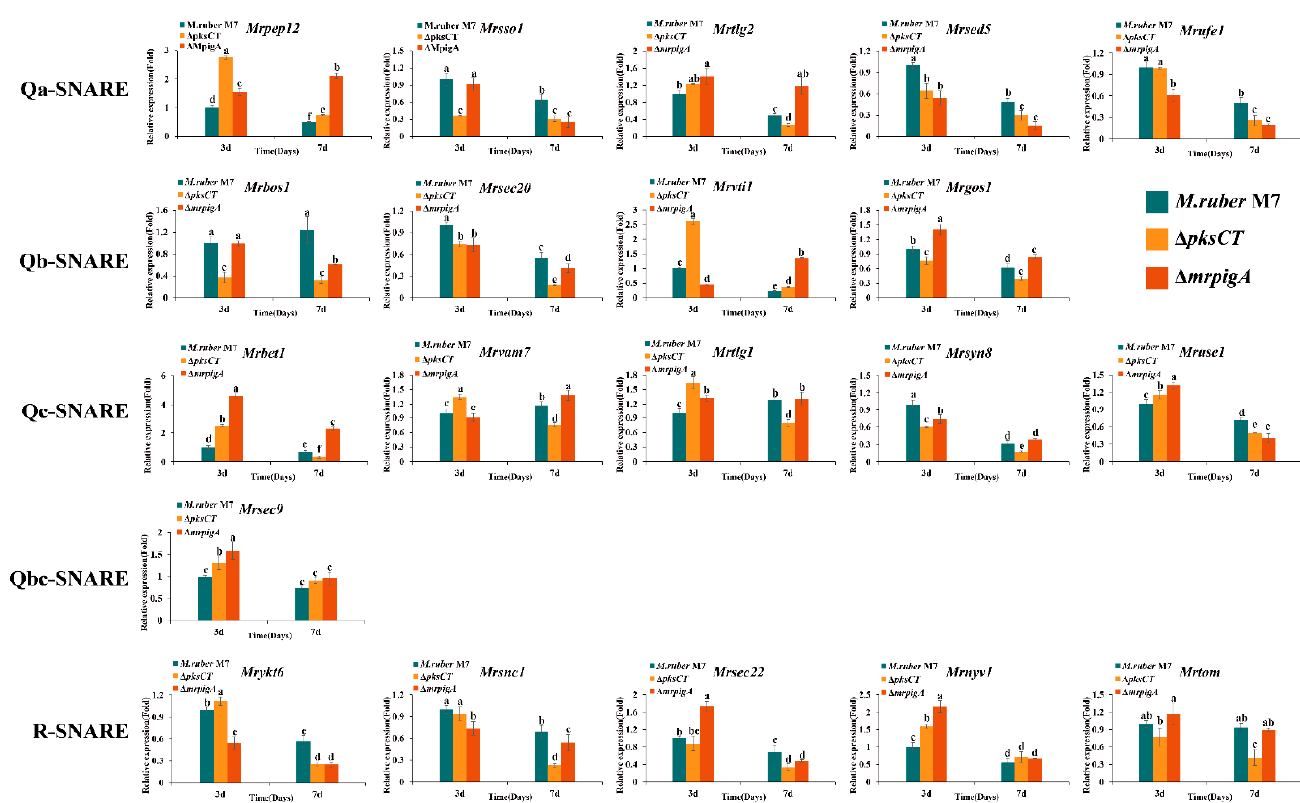
Figure 5. Expression profiles of the identified MrSNAREs in M. ruber M7, Δ pksCT and Δ mrpigA . Error bars represent means ± SD, n = 3. Y-axis indicates the relative expression level of the genes. Different lowercase letters indicate the gene expression level is significantly different ( p < 0.05).